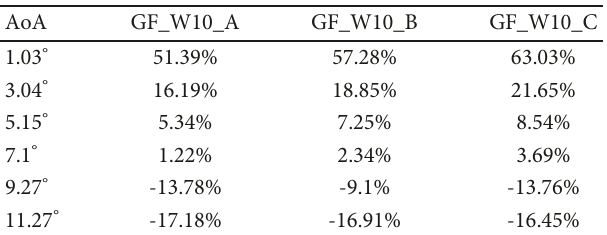
Table 2: E ff ect of GF geometry shapes on the lift-to-drag ratio for the S809 airfoil.